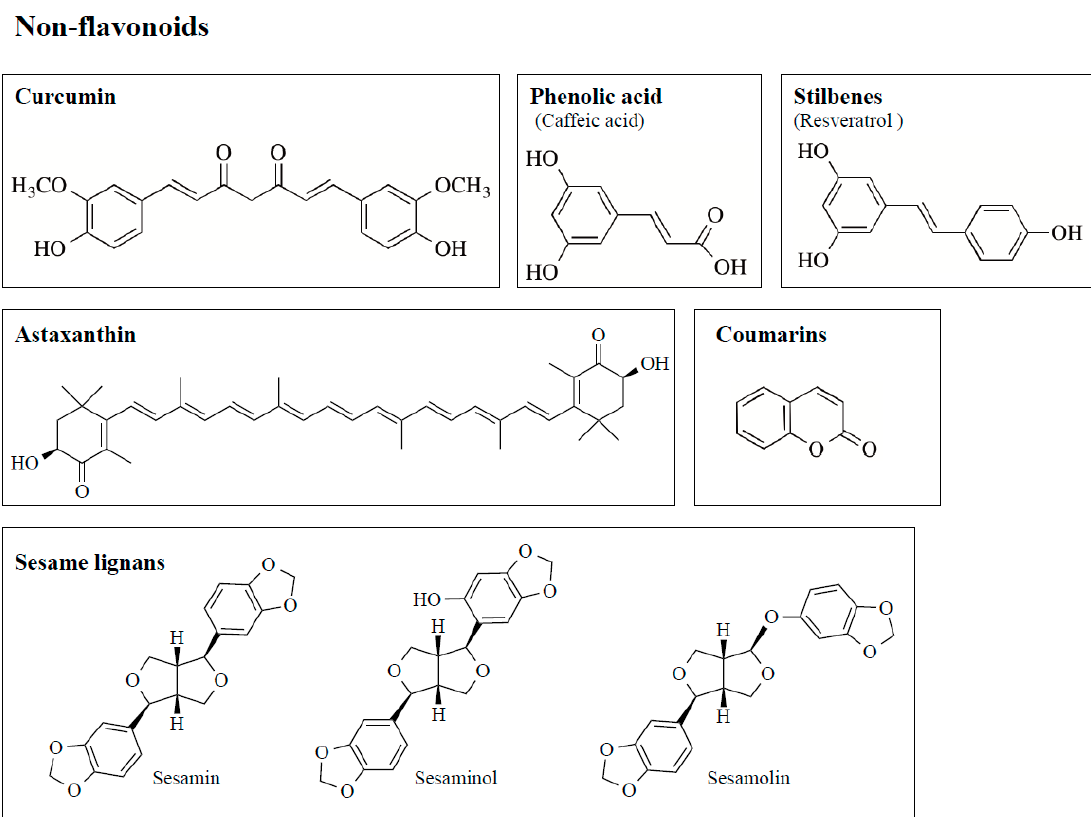
Figure 4. Structures and classification of major non-flavonoid polyphenols. Chemical structure of curcumin, phenolic acids, stilbenes (resveratrol), astaxanthin, coumarin, and sesame lignans are shown. Phenolic acids are divided into two groups; benzoic acid (gallic, protocatechulic acid) and cinnamic acid derivatives (caffeic, ferulic, p -coumaric acid) and the chemical structures are shown in Table 2.